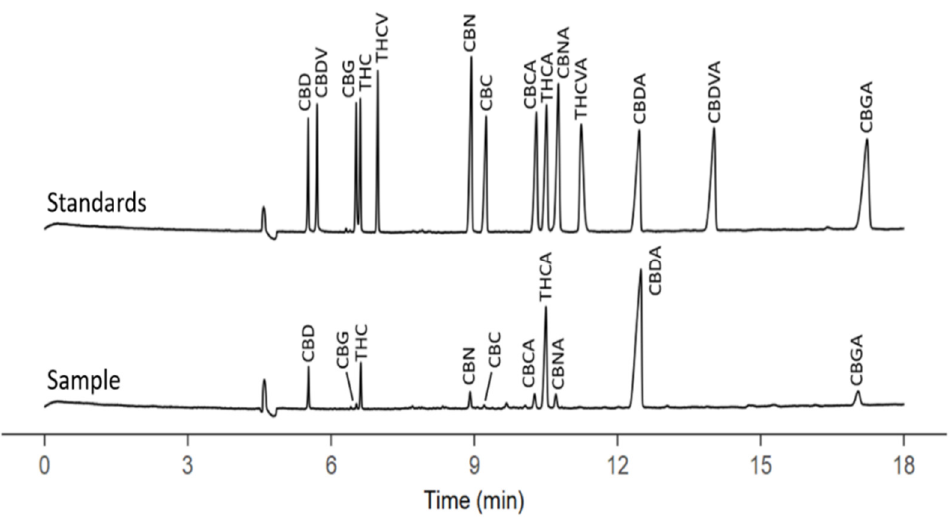
Figure 3. Electropherograms of a cannabis extract and standard mix detected at 230 nm. Both cannabis extract and standard mix were injected from methanol; 50 µ g/mL mix was injected for migration reference standard and detected at 230 nm. BGE: 6 mM NaOH and 25 µ M β -cyclodextrin in 60/40 acetonitrile/water. 450 V/cm field was applied to the capillary for 19 min.